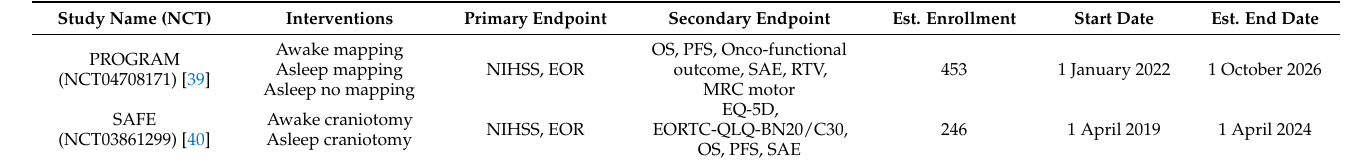
Table 1. Ongoing clinical trials for glioma